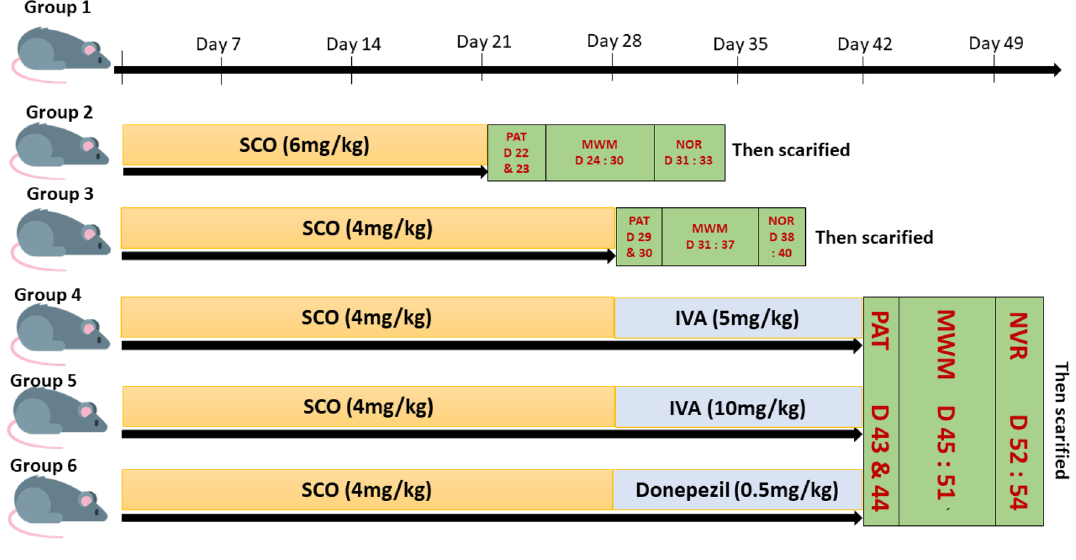
Figure 12. The timeline graphical representation. Sco scopolamine, IVA ivabradine, PAT passive avoidance test, MWM Morris water maze, NOR novel object